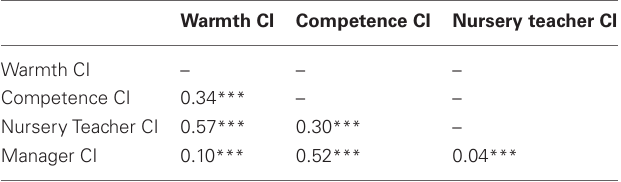
Table 2 | Correlation of pixel luminance values across 512 × 512